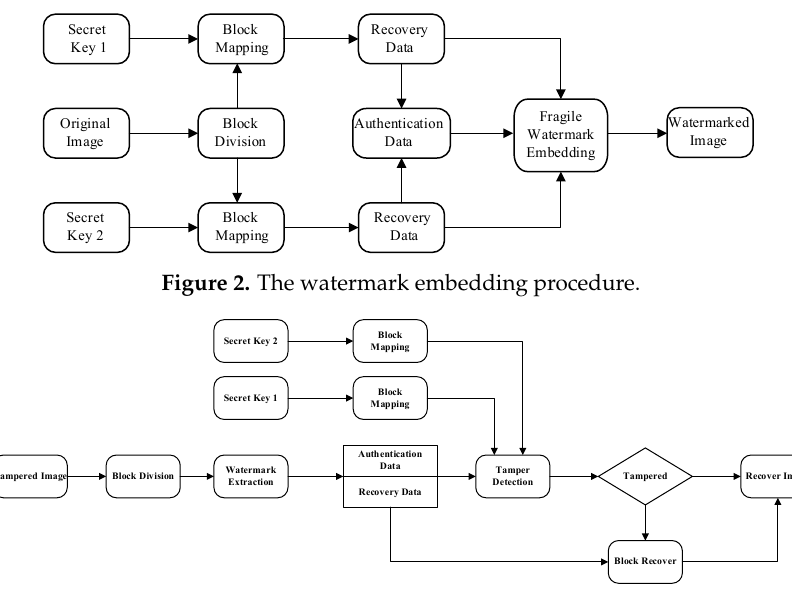
Figure 3. The tamper detection and recovery